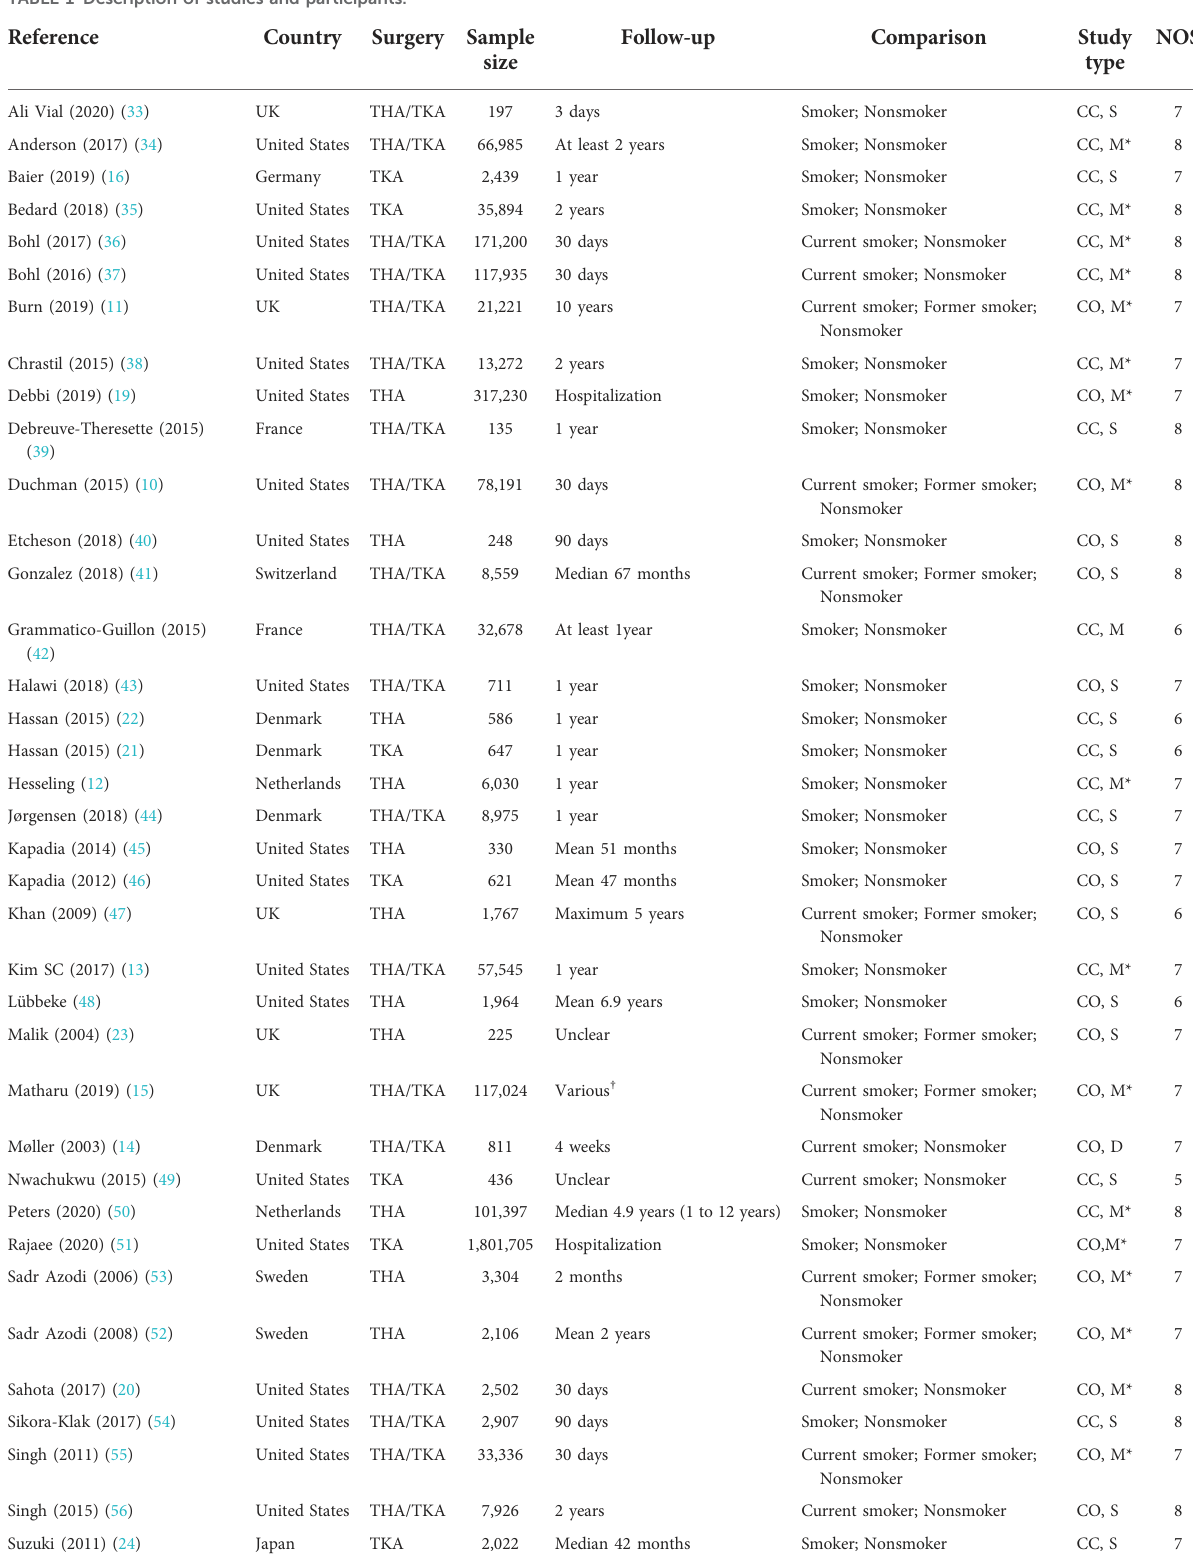
TABLE 1 Description of studies and